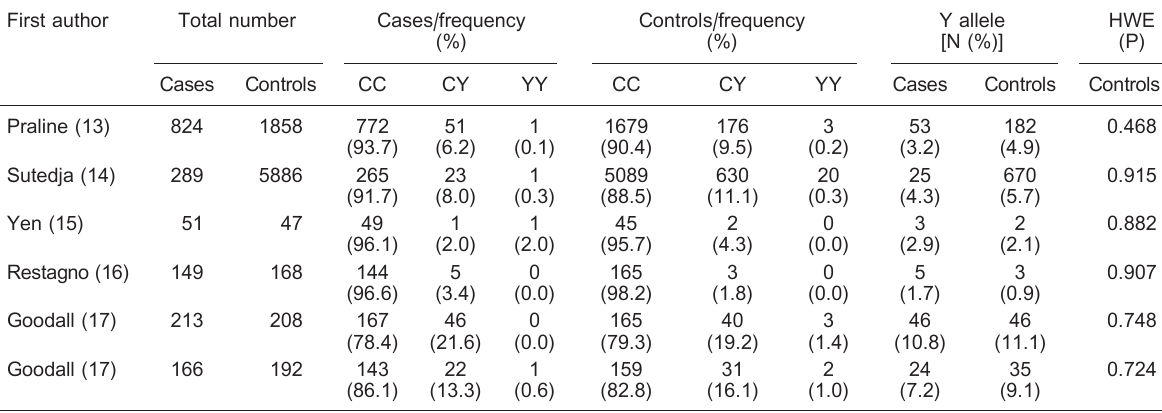
Table 1. Distribution of C282Y (rs1800562) genotypes and allele frequencies among ALS cases and controls, and P values of HWE in